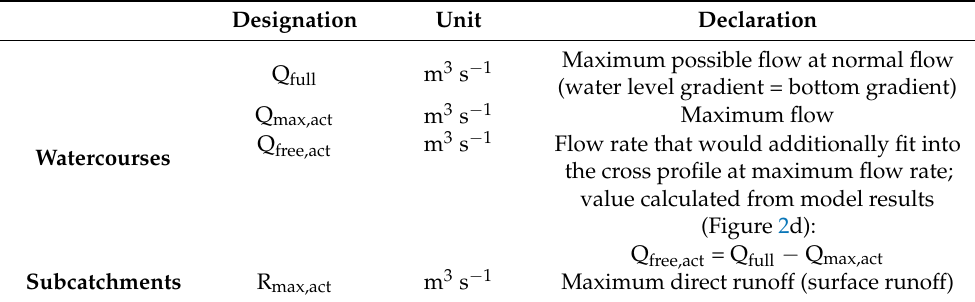
Table 2. Flood characteristics for the actual state applied in the SWR based on scenario simulations with defined rain